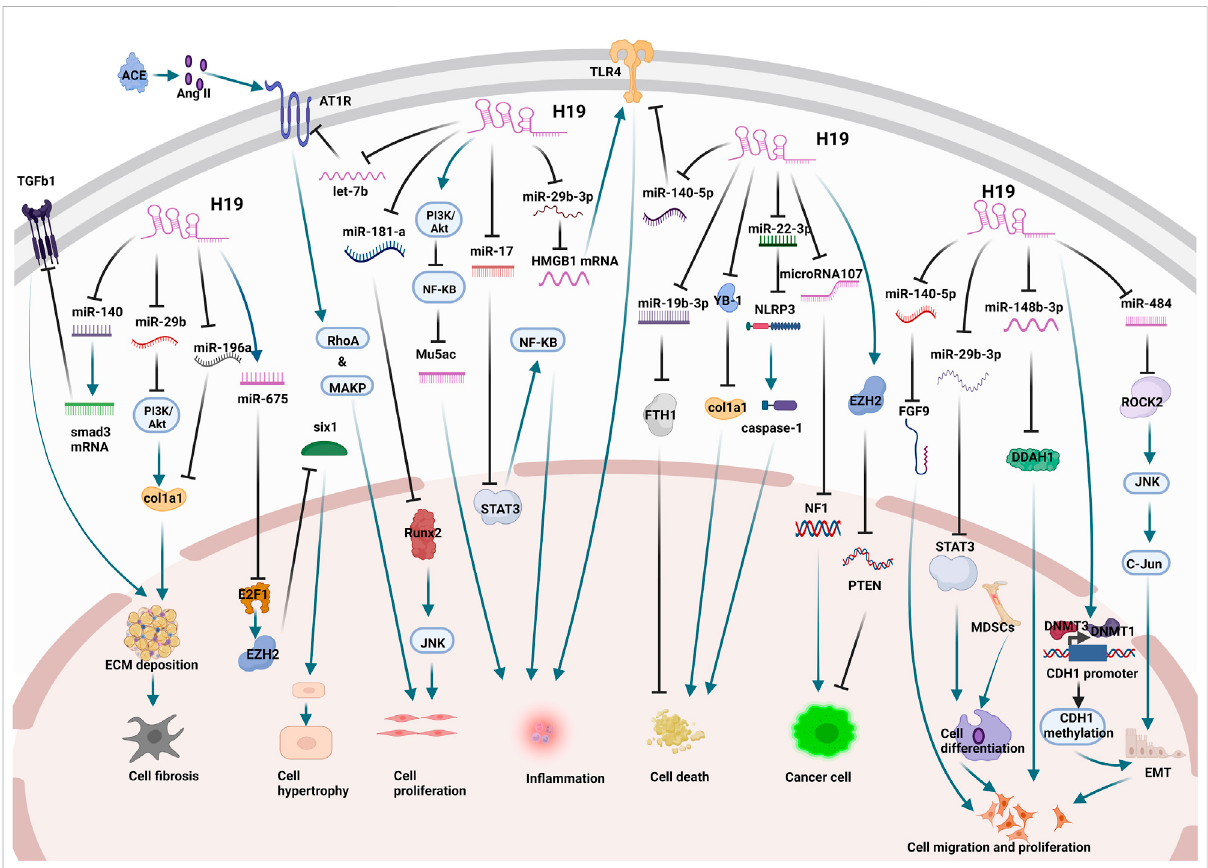
FIGURE 2 The mechanisms and related targets of H19 in lung diseases. H19 acts as a sponge for miR-140, miR-29b, and miR-196a to promote cellular fi brosis.H19promotescellhypertrophybysplicingtoproducemiR-675.H19actsasaspongeformiR-21andmiR-181atopromotecellproliferation. H19 promotes in fl ammation by acting as a sponge for miR-17, miR-29b-3p, and miR-140-5p and regulating the PI3K/Akt pathway through epigenetic pathways. H19 regulates cell death by binding to YB1 and acting as a sponge for miR-22-3p and miR-19b-3p. H19 promotes cell carcinogenesis by acting as a sponge for microRNA107 and regulating EZH2 expression through epigenetic pathways. H19 acts as a miR-29b-3p, miR-148b-3p, and miR-484 sponge and regulates the expression of CDH1 promoter through epigenetic pathways to promote cancer cell proliferation and